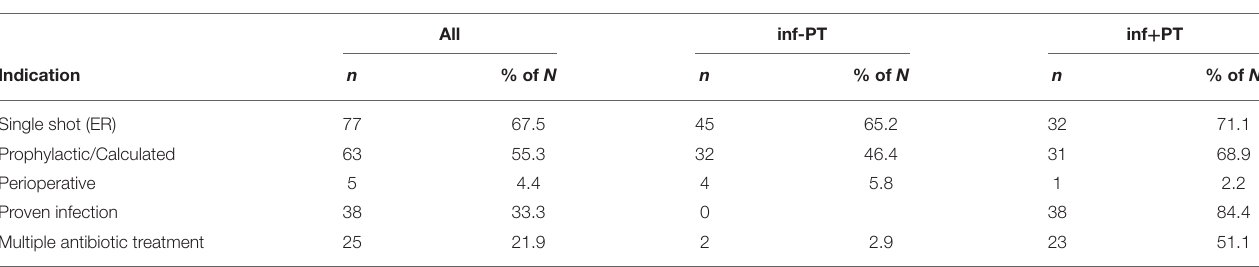
TABLE 4 | Indications of antibiotic therapy in trauma patients.